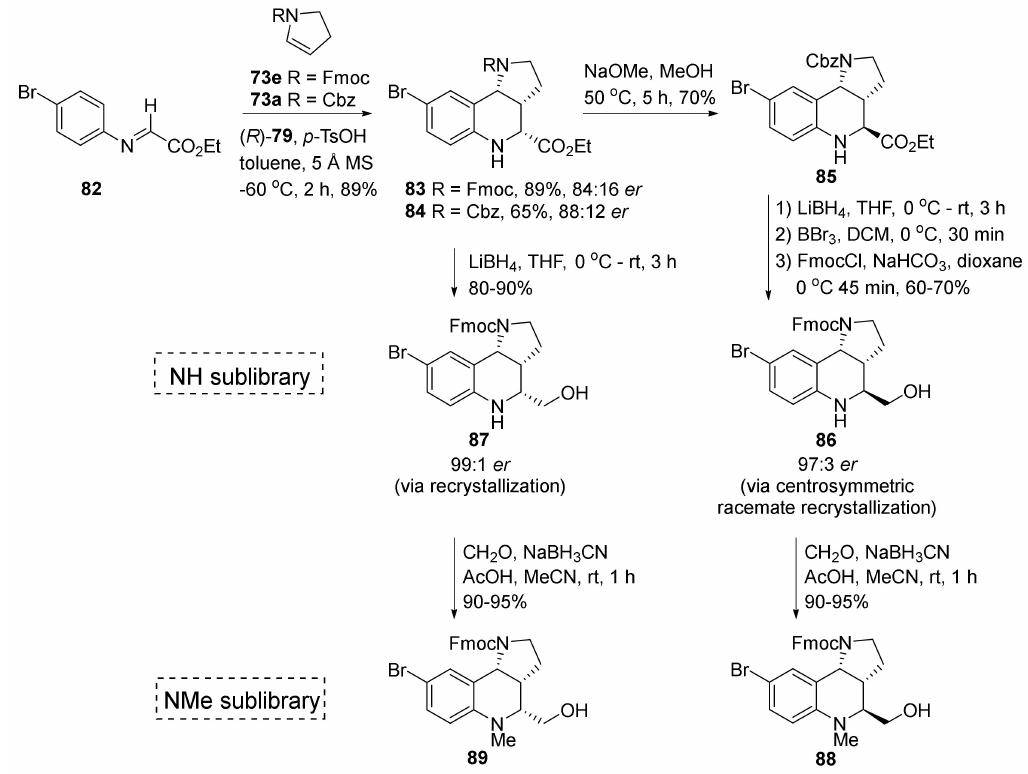
Scheme 13. Large scale scaffold synthesis by Marcaurelle and co-workers. The pyrroloquinoline scaffold was synthesized via the urea 79 catalyzed Povarov reac- tion between aromatic imine 82 and dihydropyrrolidine 73a or 73e (Scheme 13). Fmoc- and Cbz-protected pyrroloquinolines 83 and 84 were obtained in high yield and enantiomeric ratio. The imine 82 tended to hydrolyze when the reaction was run at larger scale. To solve this hydrolysis issue, the Brønsted acid NBSA initially used in the Jacobsen group was replaced by anhydrous p -toluene sulfonic acid ( p -TsOH) when the reaction was conducted on gram